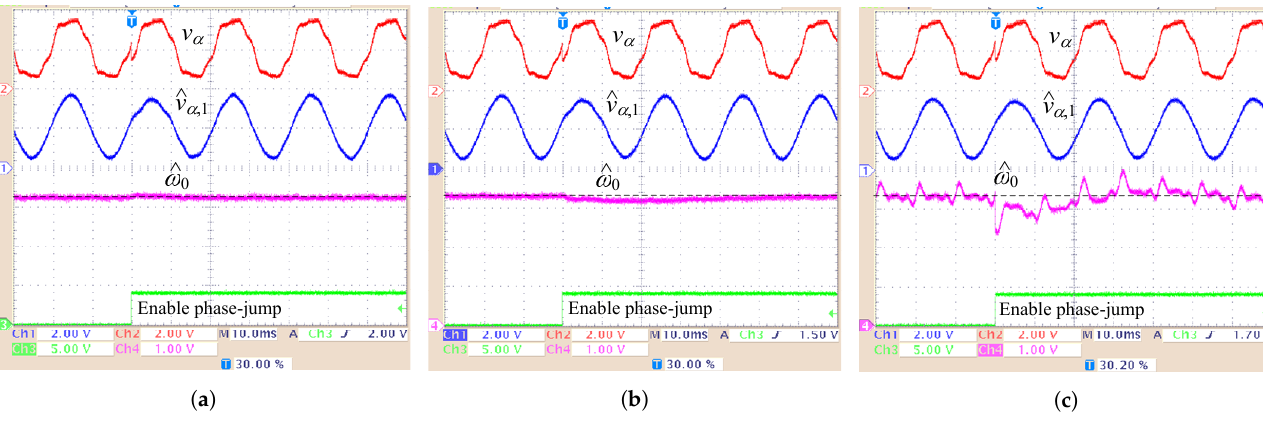
Figure 12. Transient responses due to a phase jump of − 30 degrees, while maintaining a constant f 0 = 50 Hz of ( a ), the proposed SOHO-based scheme, ( b ) the SOGI-based FLL scheme, and ( c ) the SRF-based PLL: (from top to bottom) v α , ˆ v α ,1 ( y -axis: 400 V/div), ˆ ω 0 ( y -axis: 97.66 rad/s/div), and (bottom) phase-jump enable signal ( x -axis: 10 ms/div in all plots).